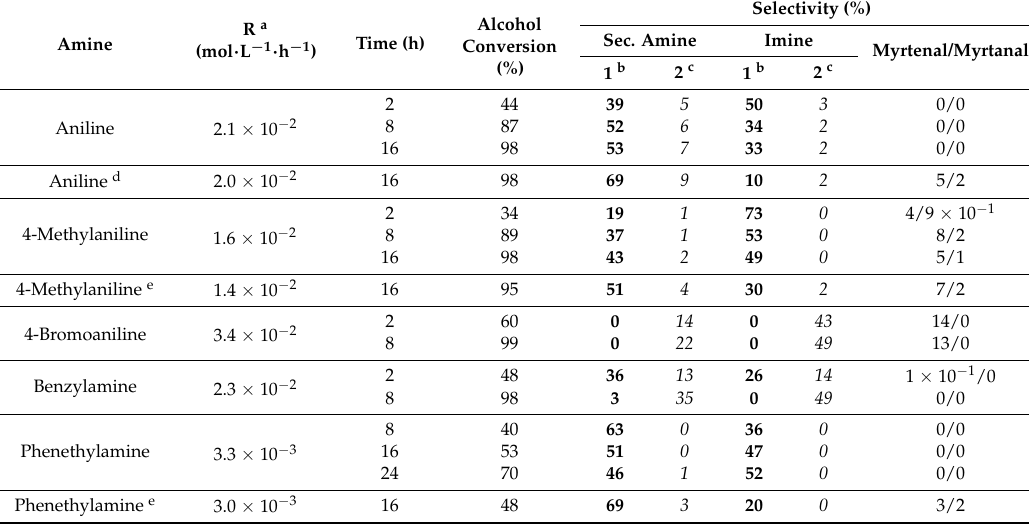
Table 13. Effect of amine structure on catalytic behavior of one-pot myrtenol amination. The